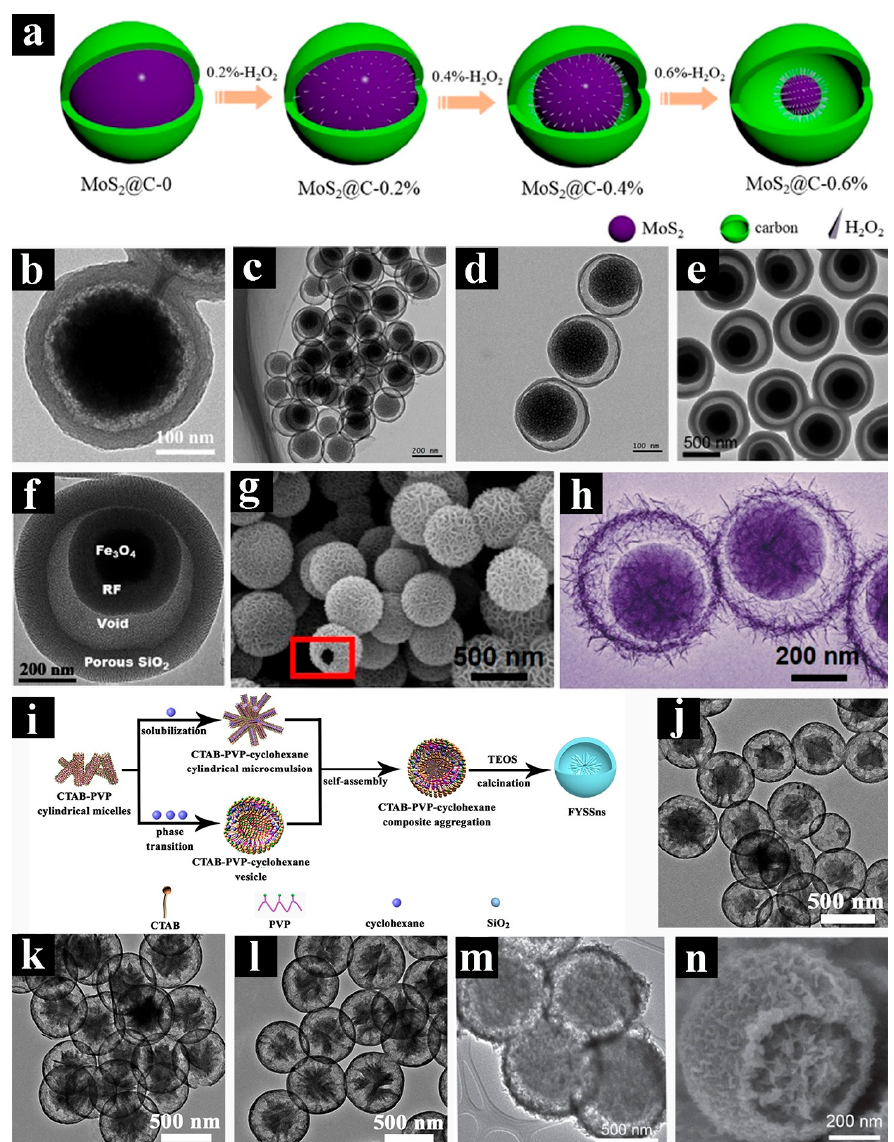
Figure 4. Schematic demonstration and graphical illustration of the single shell with single yolk spherical structure: ( a ) Schematic illustration of preparation of the yolk–shelled MoS 2 @C microspheres with di ff erent H 2 O 2 contents, ( b ) TEM image of MoS 2 @C-0.4% microspheres. ( c , d ) TEM images of SiO 2 @C. ( e , f ) TEM images of the yolk–shelled Fe 3 O 4 @RF@void@mSiO 2 . FESEM image ( g ) and